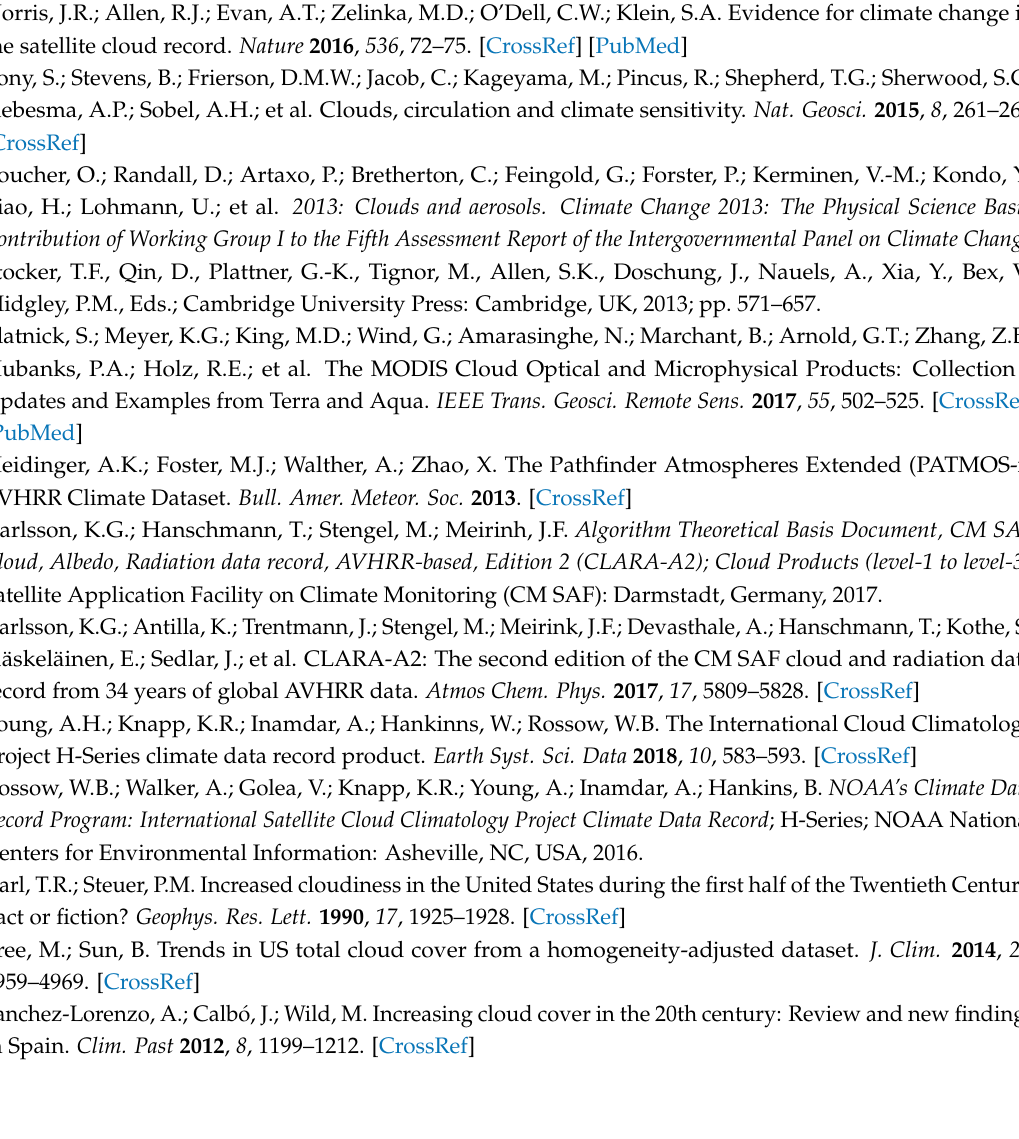
Figure S1: European Geographical difference (in absolute terms) between ISCCP-H and CLARA-A2 TCC for (a) January, (b) April, (c) July and (d) October. Results are averaged over the 29-year period 1984-2012. Figure S2. Global geographical difference (in absolute terms) between ISCCP-H and CLARA-A2 TCC for (a) January, (b) April, (c) July and (d) October. Results are averaged over the 29-year period 1984-2012. Figure S3. Latitudinal dependence of the mean satellite zenith angle of CLARA-A2 and ISCCP-H over Europe (30 ◦ –70 ◦ N). For ISCCP-H two curves are plotted: the lower and upper curves show the mean satellite zenith angle at a longitude of 0 ◦ and 30 ◦ E, respectively. For latitudes larger than 50 ◦ N the CLARA-A2 and ISCCP-H curves overlap. Figure S4. Seasonal variation of TCC averaged over all ECA&D stations (in blue) south (left) and north (right) of 55N and the corresponding grid cells of ISCCP-H (in red) and CLARA-A2 (in black). These results are similar to those of Figure 8b of the manuscript but given separately for northern and southern